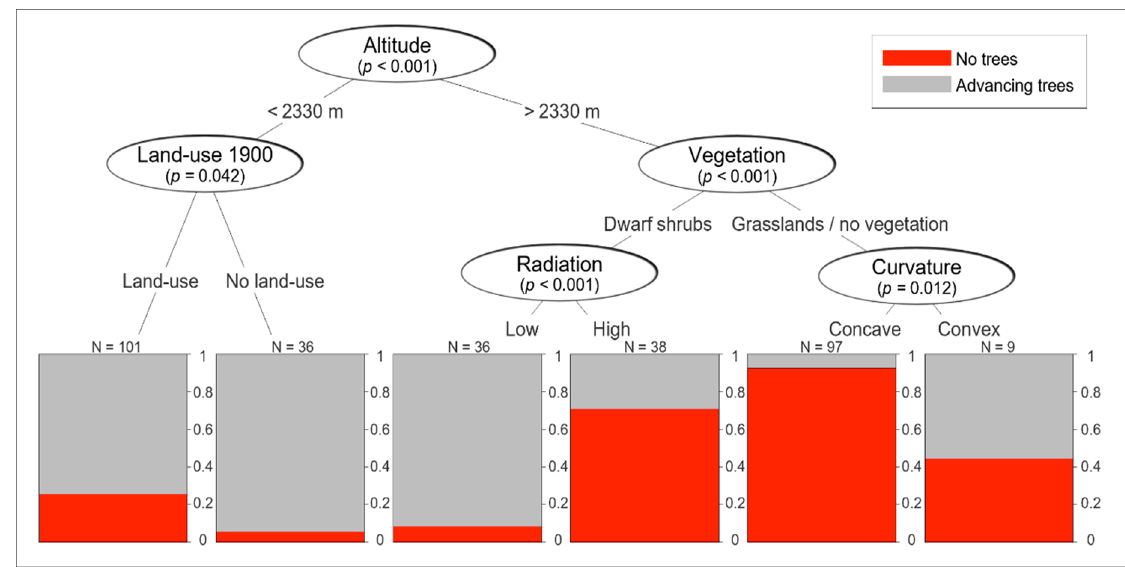
Figure 5. Decision tree showing the ecological factors that significantly influenced treeline advance between 1972 and 2012. The analysis was based on 164 raster cells classified as advance and 164 randomly chosen raster cells without advancing trees.